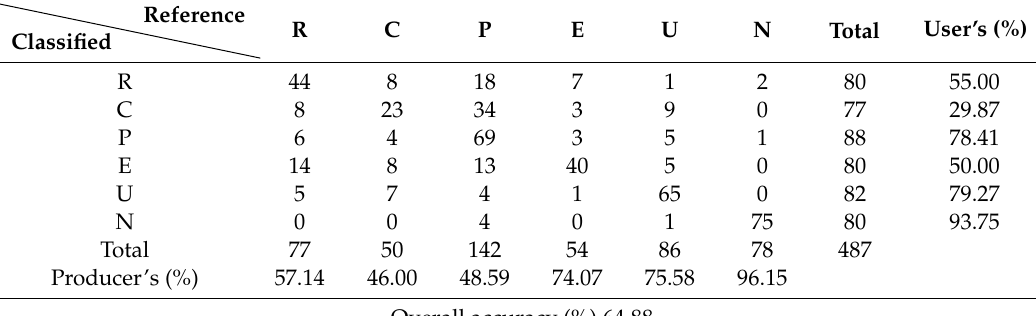
Table 5. Confusion matrix of gird level land use mapping.